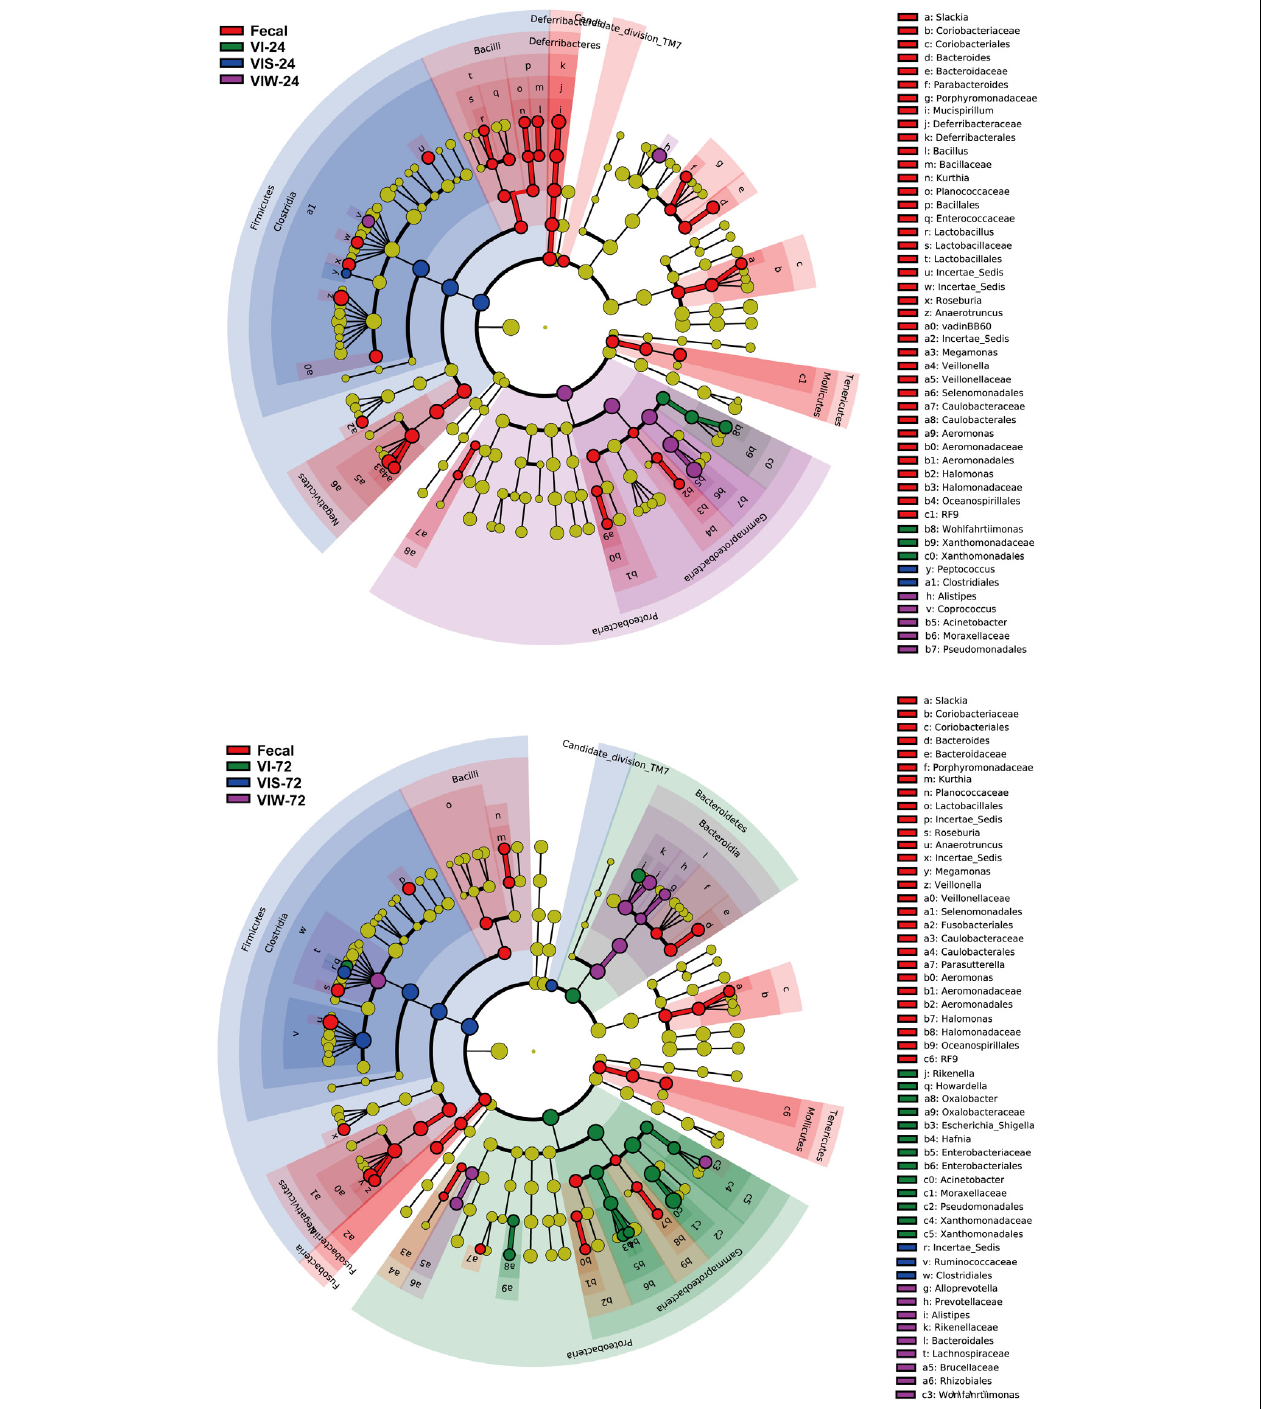
FIGURE 4 | Identification of significantly different bacteria using LEfSe. “Fecal” represents the volunteers’ original fecal samples. “VIW” and “VIS” represent fermented samples after adding EPS-m2 and starch, respectively. “24” and “48” represents the fermentation time.